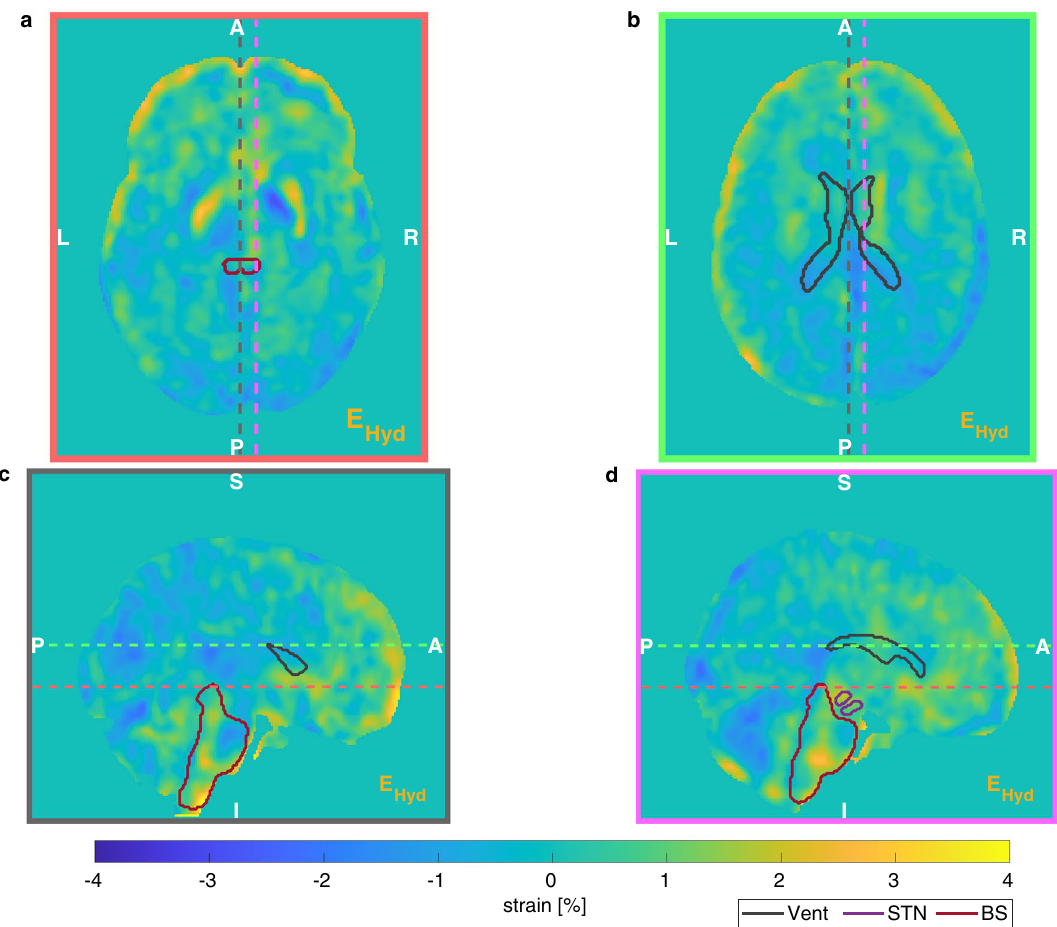
Figure 4. Distribution of the hydrostatic component at two axial ( a and b ) and two sagittal ( c and d ) slices. As reference, three ROI (Vent, STN, BStem) are delineated. Dashed coloured lines represent the position of the other slices. In particular, slice a was positioned at the level of the anterior and posterior horns of the lateral ventricles, whereas slice c was positioned at the level of the falx